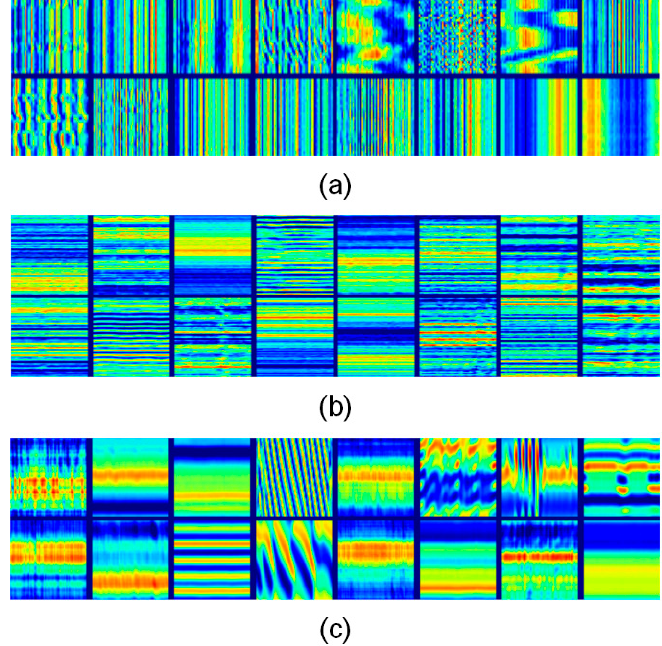
Figure 15. Visualization of the convolutional filters: ( a ) temporal filters; ( b ) frequency filters; ( c ) texture filters.